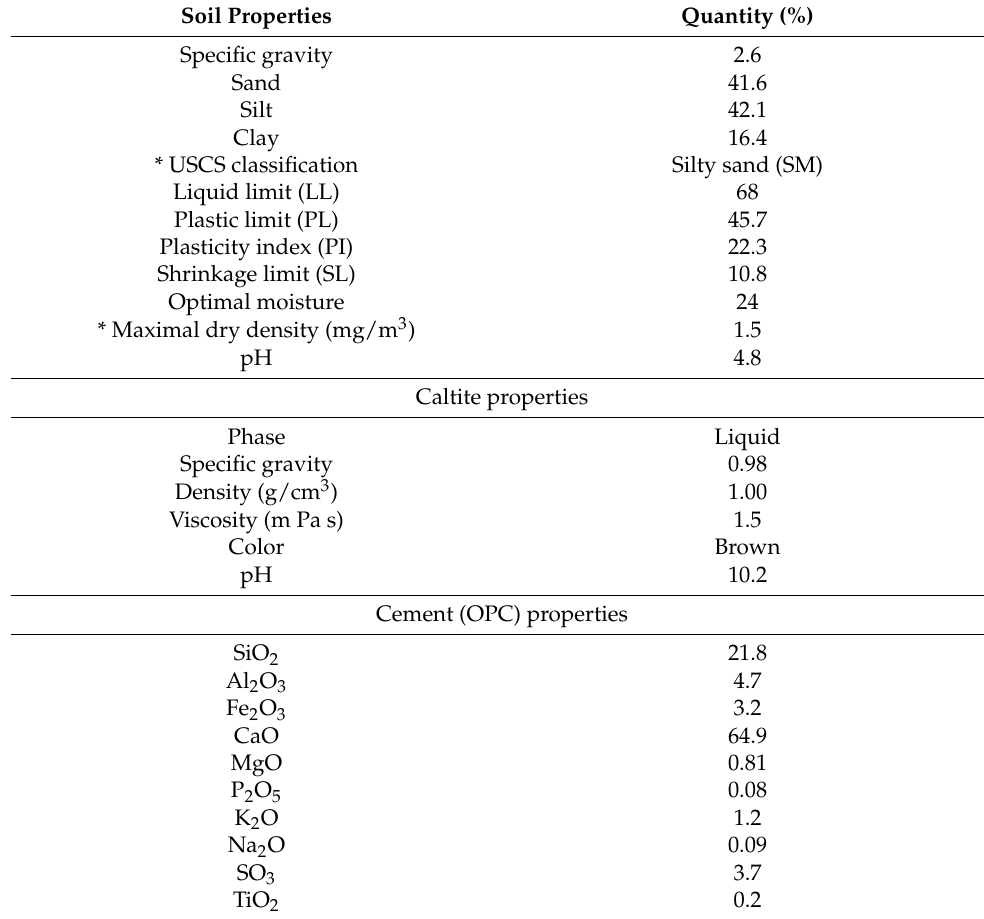
Table 1. Physical properties of lateritic soil and caltite used in this study. All units in the soil properties are in % except